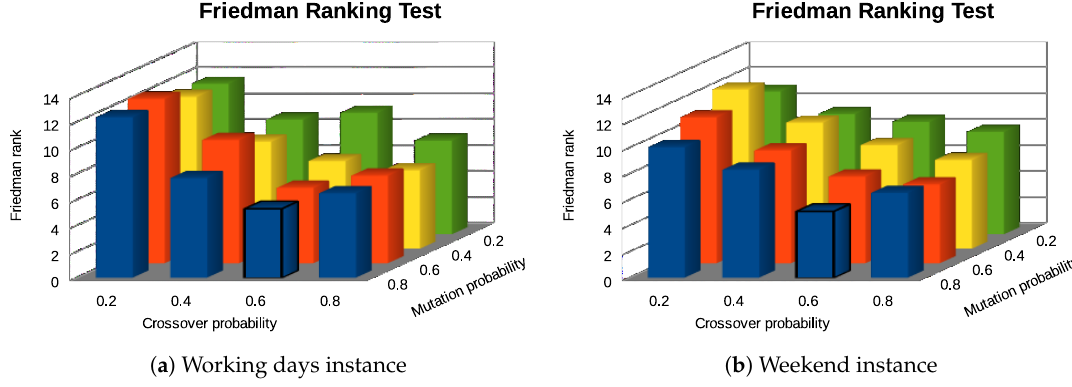
Figure 10. Friedman Rank test results for parameterization experiments.